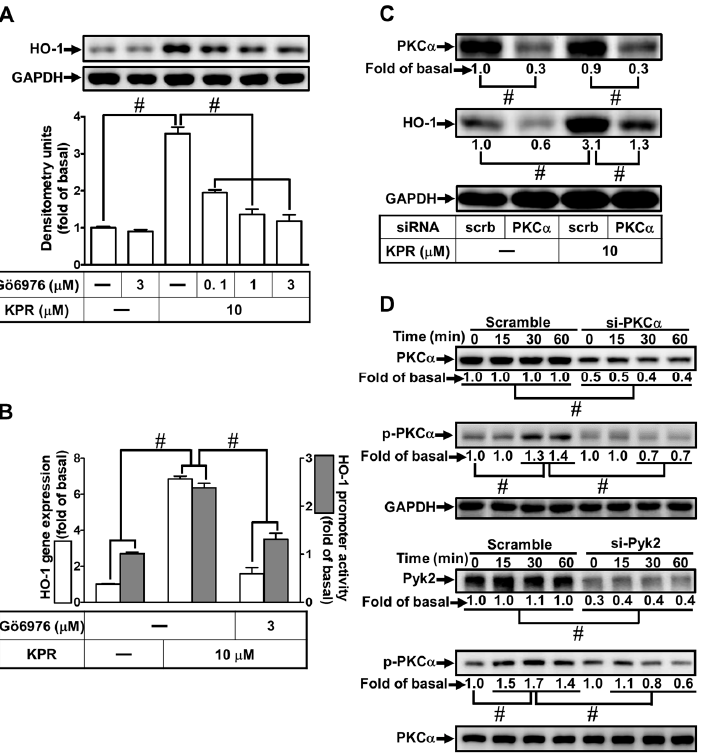
Figure 7. PKC α is required for KPR-induced HO-1 Expression. ( A ) HPAEpiCs were pretreated with various concentrations of G˝o6976 for 1 h and then incubated with DMSO or KPR (10 µ M) for 16 h. The protein expression of HO-1 was determined by Western blot using GAPDH as a loading control. ( B ) Cells were pretreated with or without G˝o6976 (3 µ M) for 1 h and then incubated with DMSO or KPR (10 µ M) for the indicated time intervals. The HO-1 mRNA expression and promoter activity were analyzed by real-time PCR (6 h) and promoter activity assay (8 h), respectively. ( C ) Cells were transfected with scrambled (scrb) or PKC α siRNA, and then incubated with KPR (10 µ M) for 16 h. The protein levels of HO-1, PKC α , and GAPDH were determined by Western blot. ( D ) Cells were transfected with PKC α or Pyk2 siRNA, and then incubated with KPR (10 µ M) for the indicated time intervals. The levels of phospho-PKC α , total PKC α , and total Pyk2 were determined by Western blot. Data are expressed as mean ± SEM ( n = 5), analyzed with one way ANOVA and Dunnett’s post hoc test. # p < 0.01, as compared with the cells exposed to vehicle alone; or significantly different as